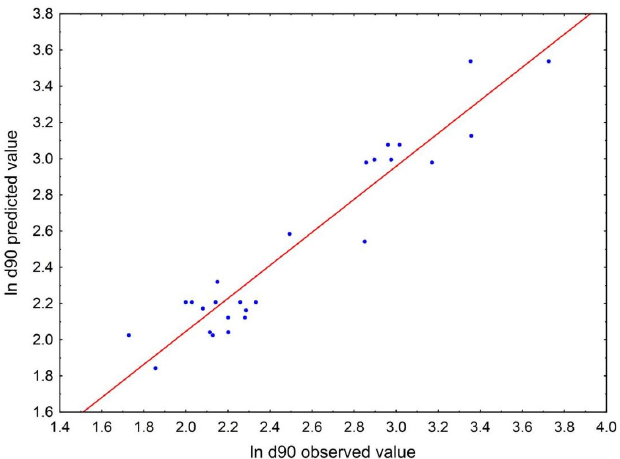
Figure A4. The correlation between observed and predicted ln d90 values by the final model (Equation (3)) for LASP parameters developed according to central composite design experiments.